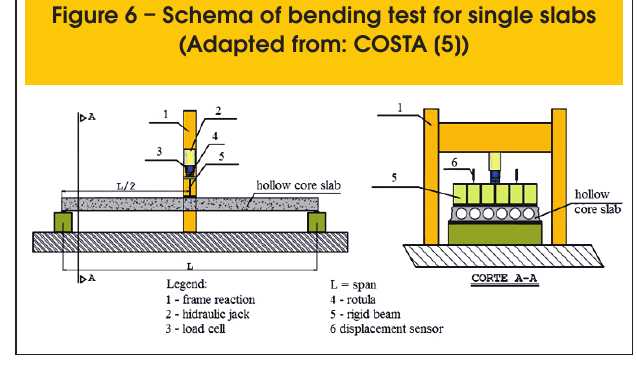
Figure 7 – Schema of bending test for continuous